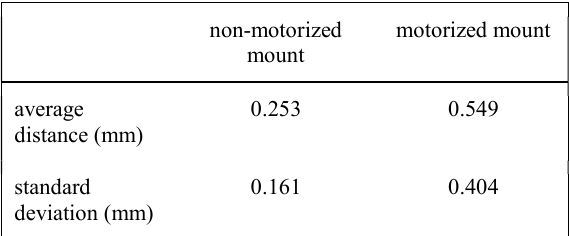
Table 2. Average distances and standard deviations of the projection centres from the mass centre that was calculated from all available camera centres after the mounts were